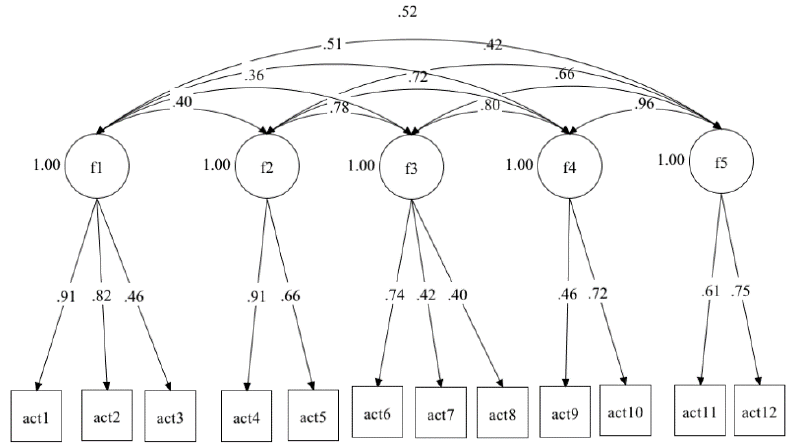
Figure 1. Factor structure of the APuP questionnaire (12-item Spanish version).